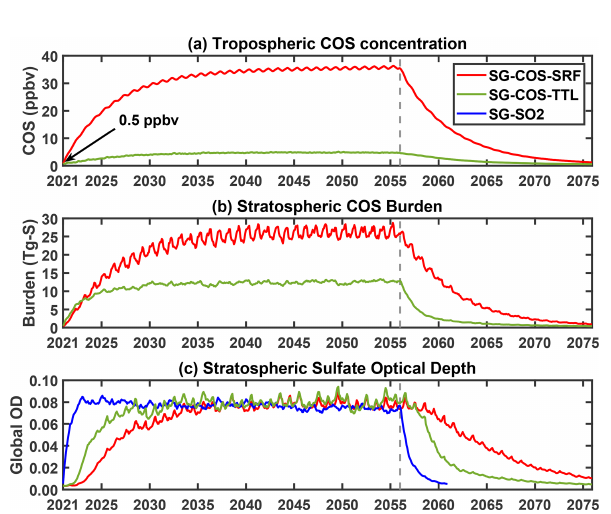
Figure 2. (a) Monthly values of globally averaged tropospheric COS volume mixing ratio (ppbv) in both SG-COS experiments. The background value of 0.5ppbv at the beginning of the simulation is highlighted. (b) Monthly values of global stratospheric COS bur- den (in Tg-S) in both SG-COS experiments. (c) Globally averaged stratospheric sulfate optical depth monthly values in SG-COS-SRF (red), SG-COS-TTL (green), and SG-SO2 (blue). The grey line in all panels indicates the time when emissions of COS and SO 2 are stopped, which is at the end of 2055.